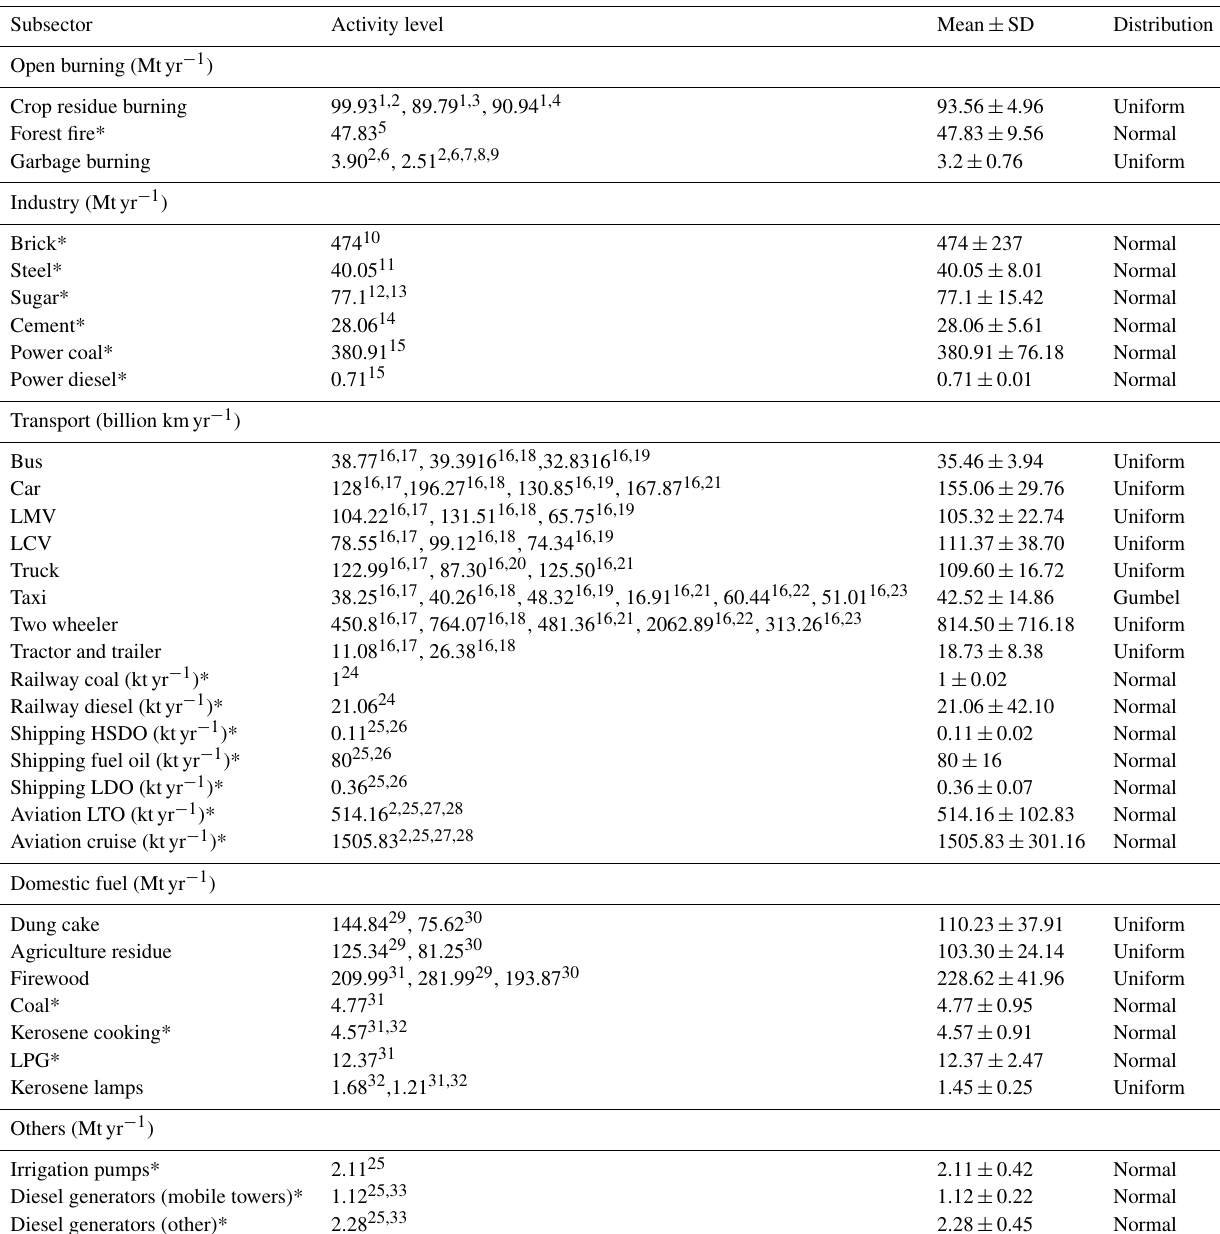
Table 1. Mean activity data, standard deviation and best-fit probabilistic